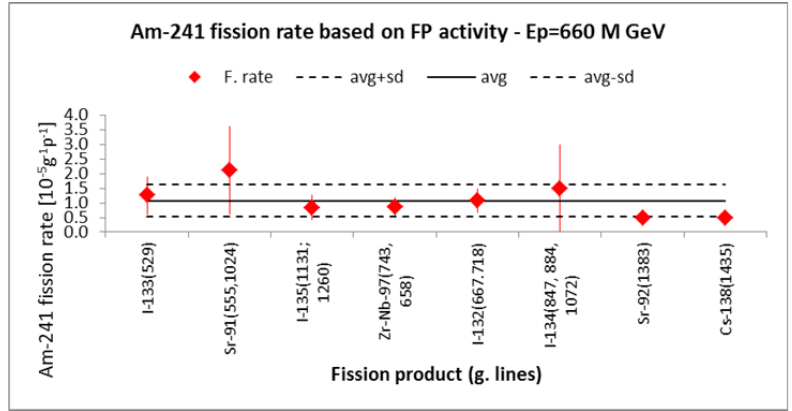
Figure 4. Am-241 fission rate FP isotope specific results